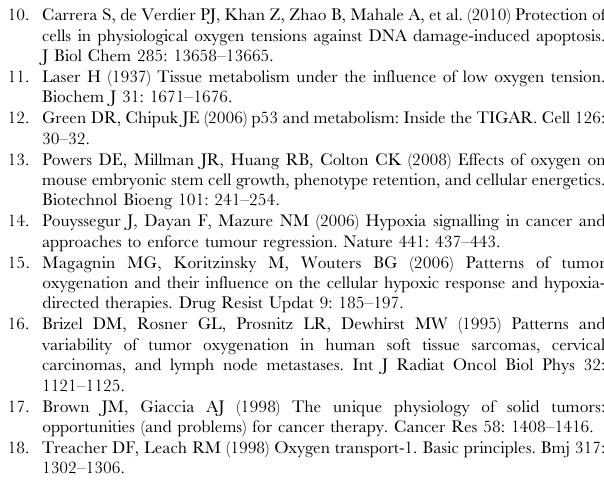
Figure S1 Western blot analysis of phospho and total p53, and p21, which are major upstream regulators of G2/M cell cycle progression and the relevance to 21% or 3% O 2 in ovarian cancer cells. O 2 insensitive cell lines are indicated by asterisk and italics.